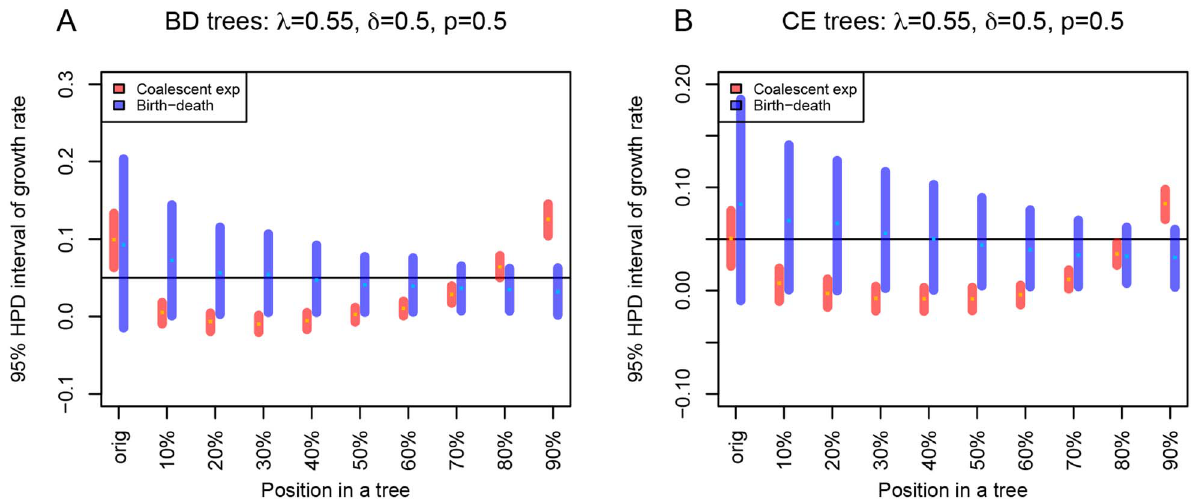
Figure 2. Influence of branch length extension in various parts of the tree on the growth rate parameter estimation. For setting l ~ 0 : 55, d ~ 0 : 5 and p ~ 0 : 5 ( R 0 ~ 1 : 1 ), we modified all 100 birth-death trees (A) and all 100 coalescent trees (B) by branch extension. The unchanged tree is denoted as ‘‘orig’’ on x-axis. We added 48 units of time, roughly corresponding to the full length of the longest trees, to the branches. We extended the branches that were present in the tree at 10% of the tree (going from the root), at 20%, 30%, 40%, 50%, 60%, 70%, 80%, 90% (see x-axis from left to right). We then re-estimated the growth rate parameter for each such tree. Unlike in previous plot, here we display a summary in form of the median values of the start and the end of the 95% HPD intervals, and the median of the medians of the posterior estimates for all 100 trees per setting.